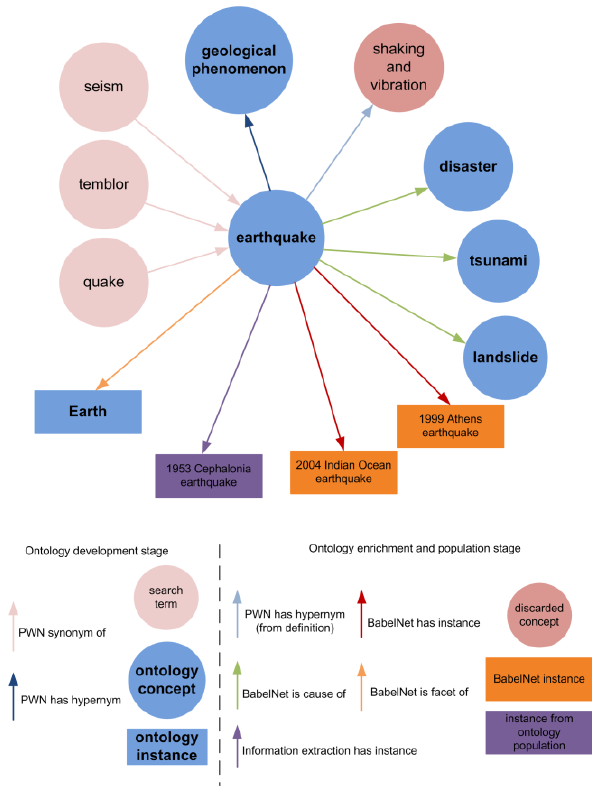
Figure 3. An example of ontology enrichment and